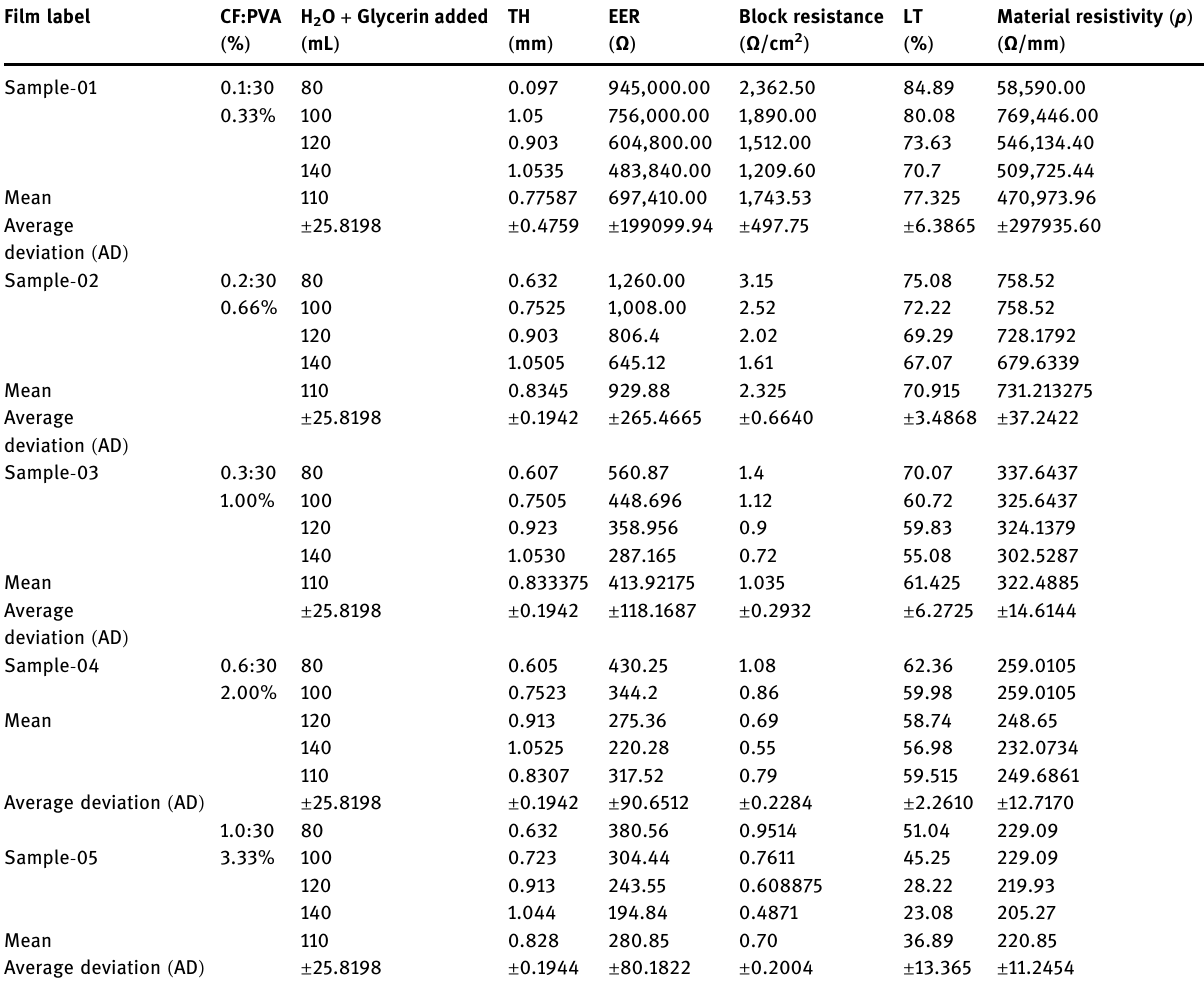
Table 4: E ff ects of CFs to PVA ratio on fi lm